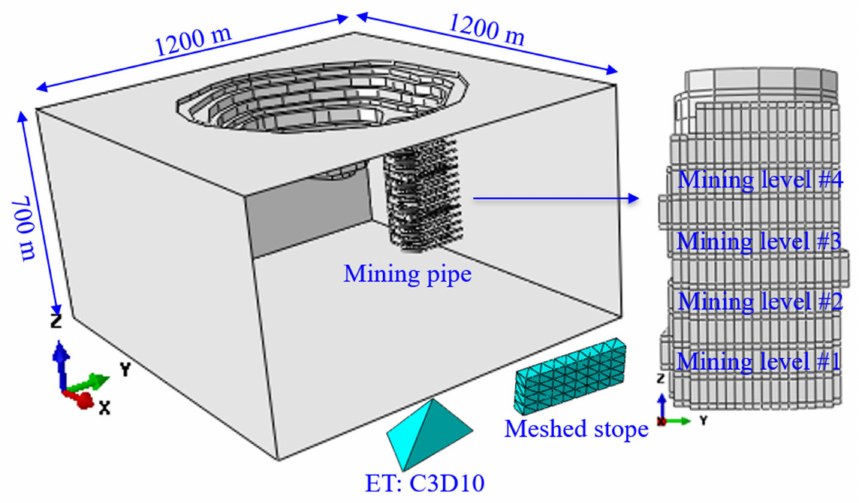
Figure 1. FEM model of the mine site and element mesh